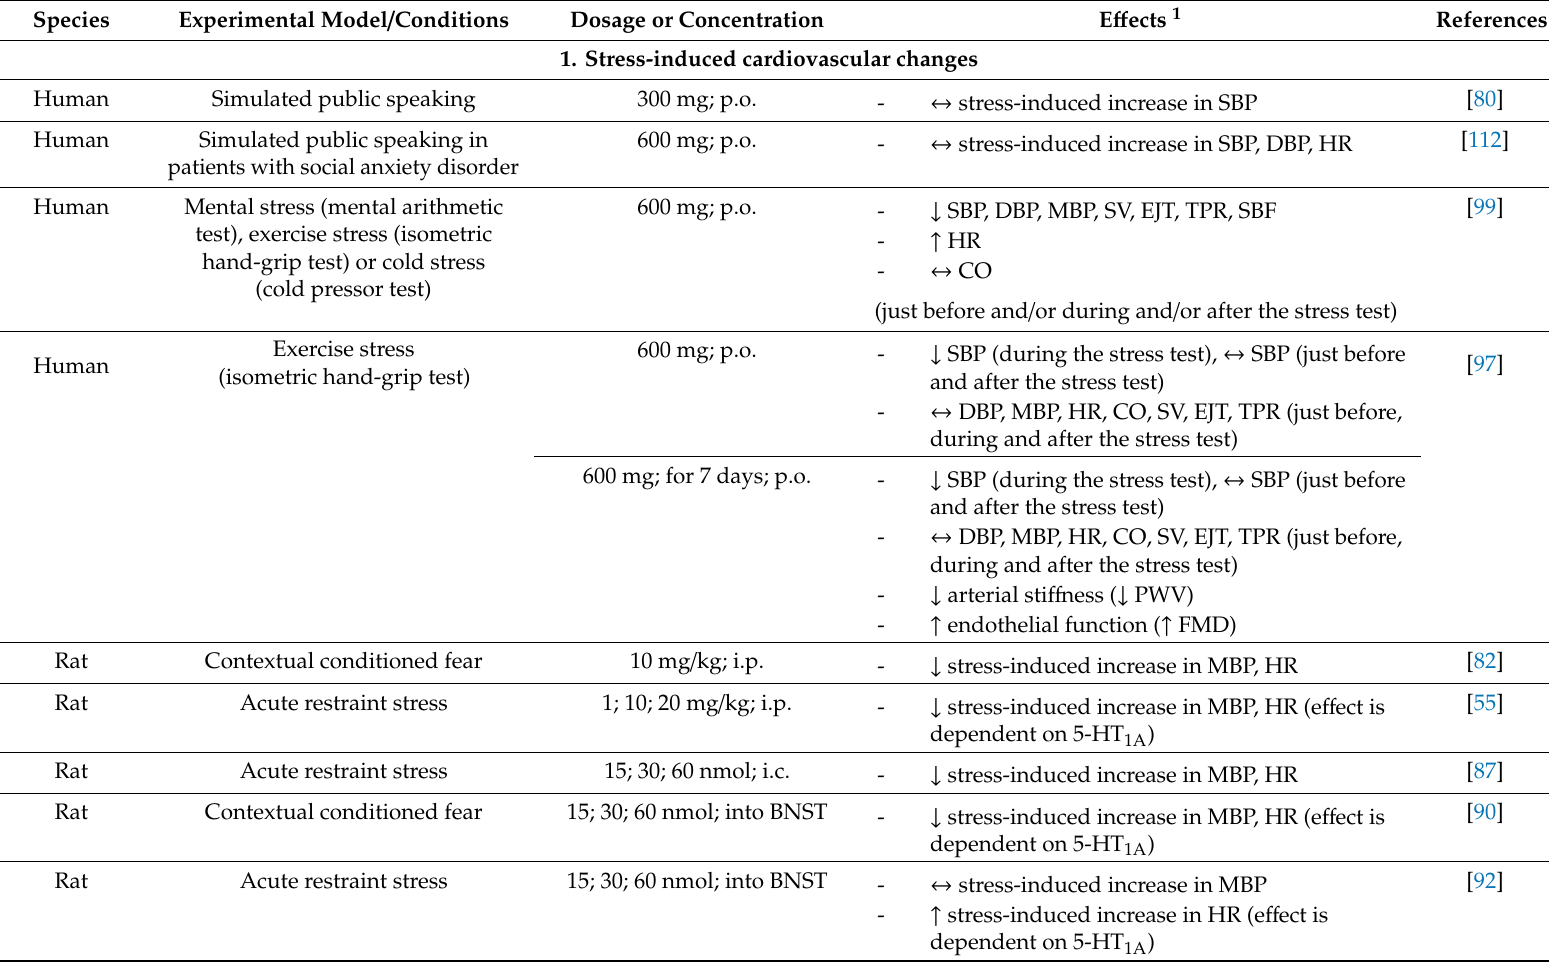
Table 4. E ff ects of cannabidiol (CBD) in cardiovascular